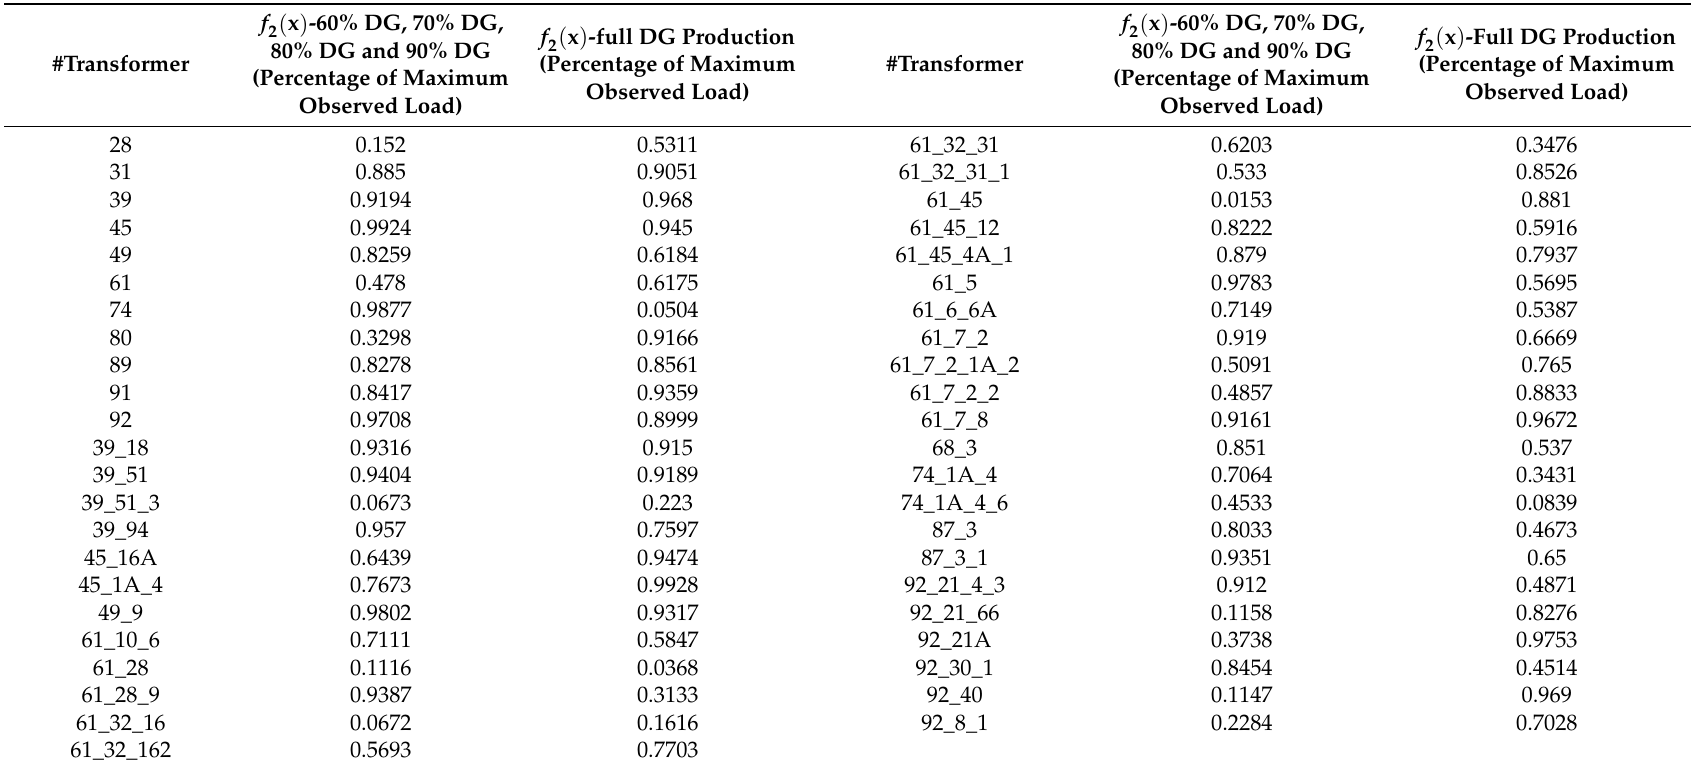
Table 4. Optimal loading per node according to f 2 ( x ) for increasing production from to 50% to full of the distributed generator’s installed